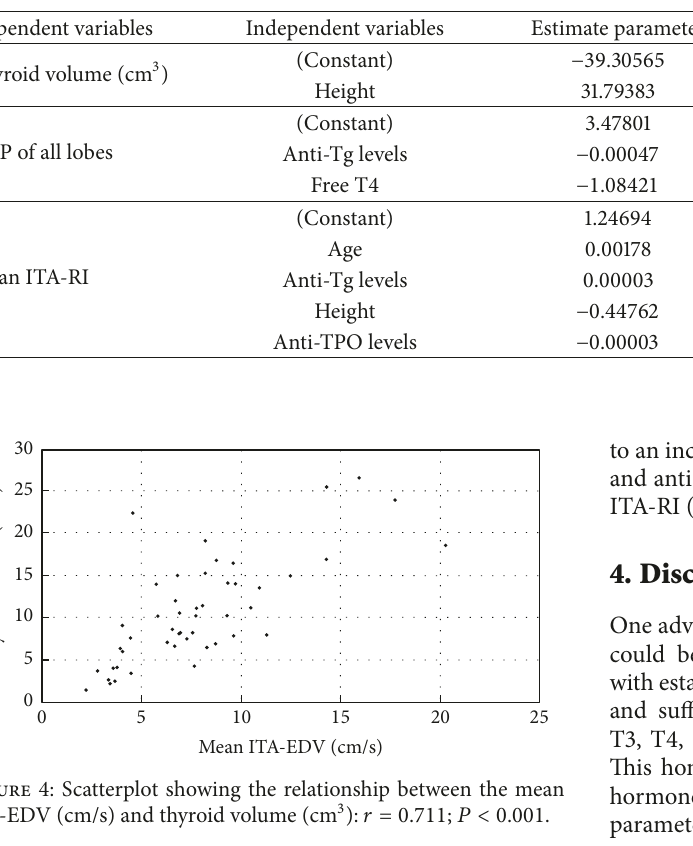
Table 3: Stepwise linear regression analysis results.